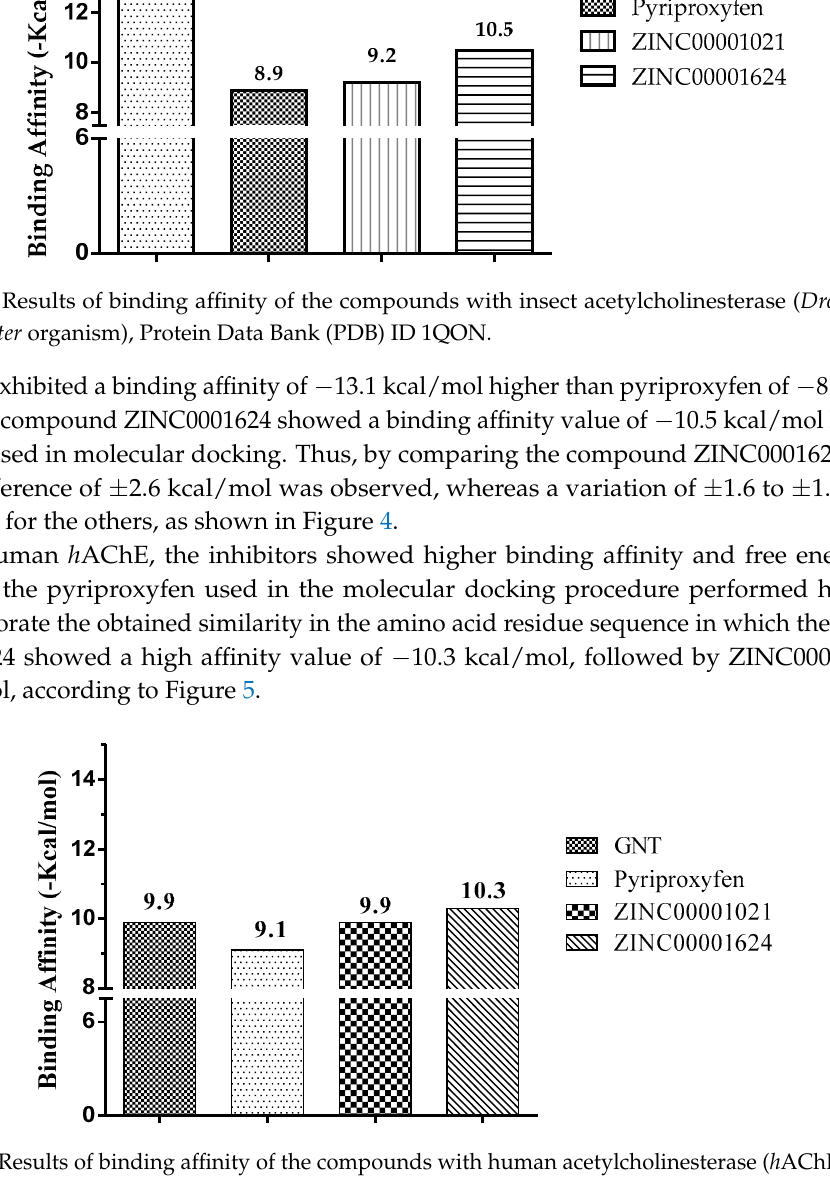
Figure 5. Results of binding affinity of the compounds with human acetylcholinesterase ( h AChE), PDB ID 4EY6.